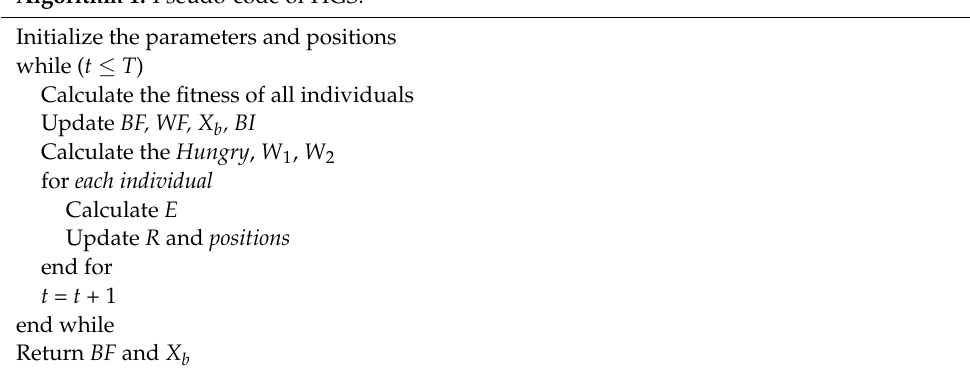
Algorithm 1. Pseudo-code of